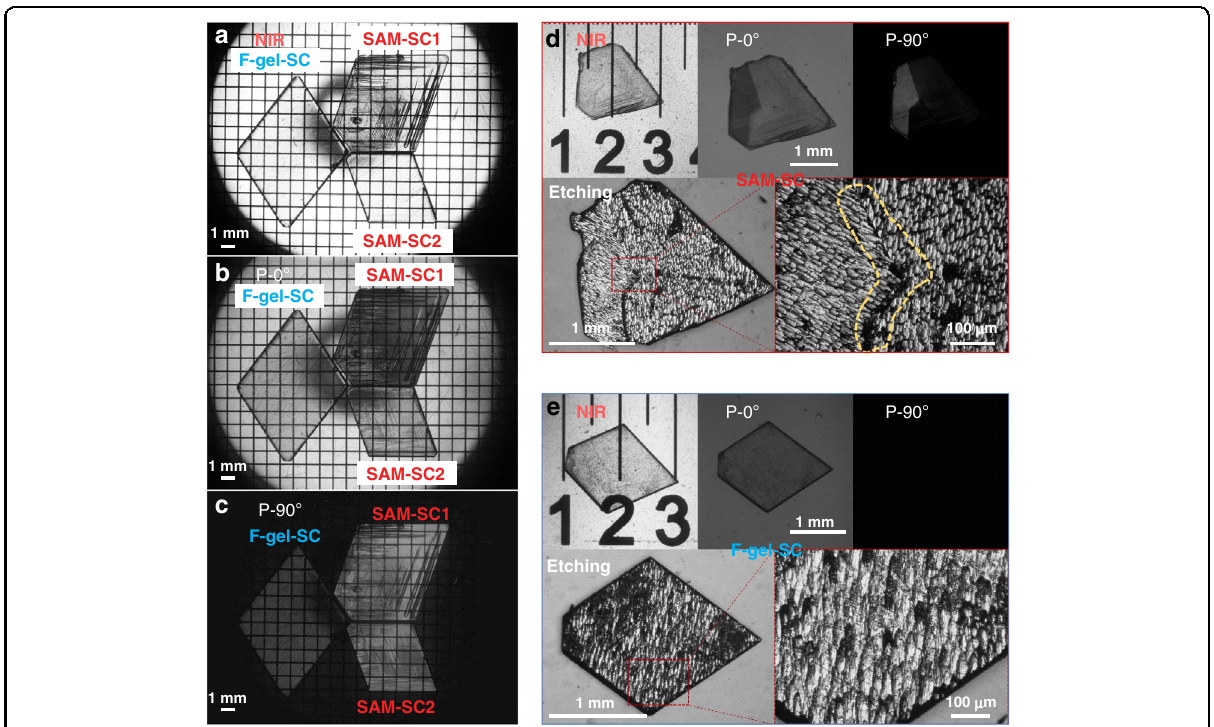
Fig. 2 NIR optical microscopy characterization of MAPbI 3 SCs. NIR optical microscopy images of crystals a without polarizers, b with parallel aligned polarizers and c with vertical aligned polarizers in the transmission mode. (F-gel-SC is grown on a soft contact substrate; SAM-SC1 is grown on a hard contact substrate; SAM-SC2 is grown on a hard contact substrate and its surface is polished.) d Polarized NIR images of crystals grown on hard substrates (top) and visible light images of crystal surfaces etched by acetone (bottom). e Polarized NIR images of crystals grown on soft substrates (top) and visible light images of crystal surfaces etched by acetone